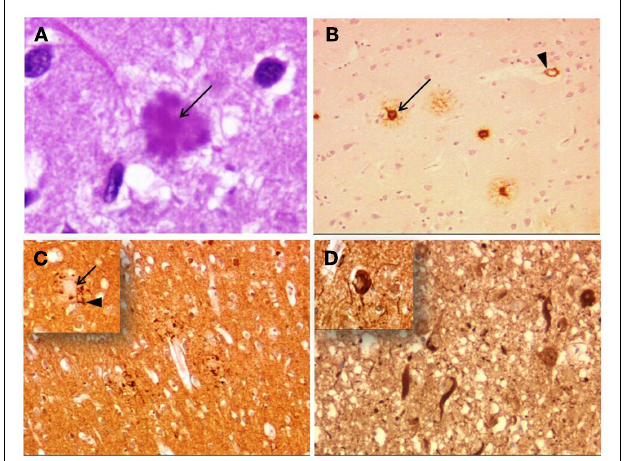
FIGURE 1 |Alzheimer’s disease neuropathology. (A) Senile plaque (hematoxylin–eosin) with amyloid core ( arrow ). (B) Senile plaques with anti-A β antibody.The amyloid core ( arrow ) is surrounded by a corona of lightly labeled A β peptide. Arrowhead indicates vascular amyloid deposition in a capillary (Cambridge Bioscience, 4G8). (C) Neuritic plaques immunostained with tau antibody.The arrow indicate the core of the plaque and arrowhead the tau-positive processes of the neuritic crown (inset). (D) Flame-shaped neurofibrillary tangles. Inset shows a globose neurofibrillary tangle (Autogen Bioclear, AT8). Magnification, 400 × (A) , 100 × (B,C) , and 200 × (D)